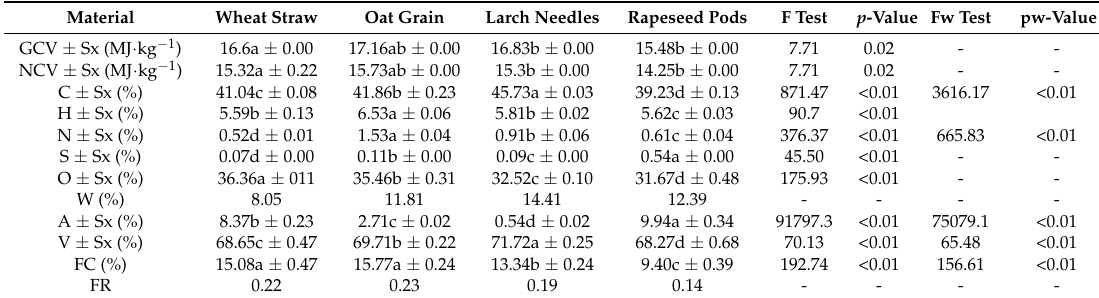
Table 1. Results of technical and elemental analysis of examined